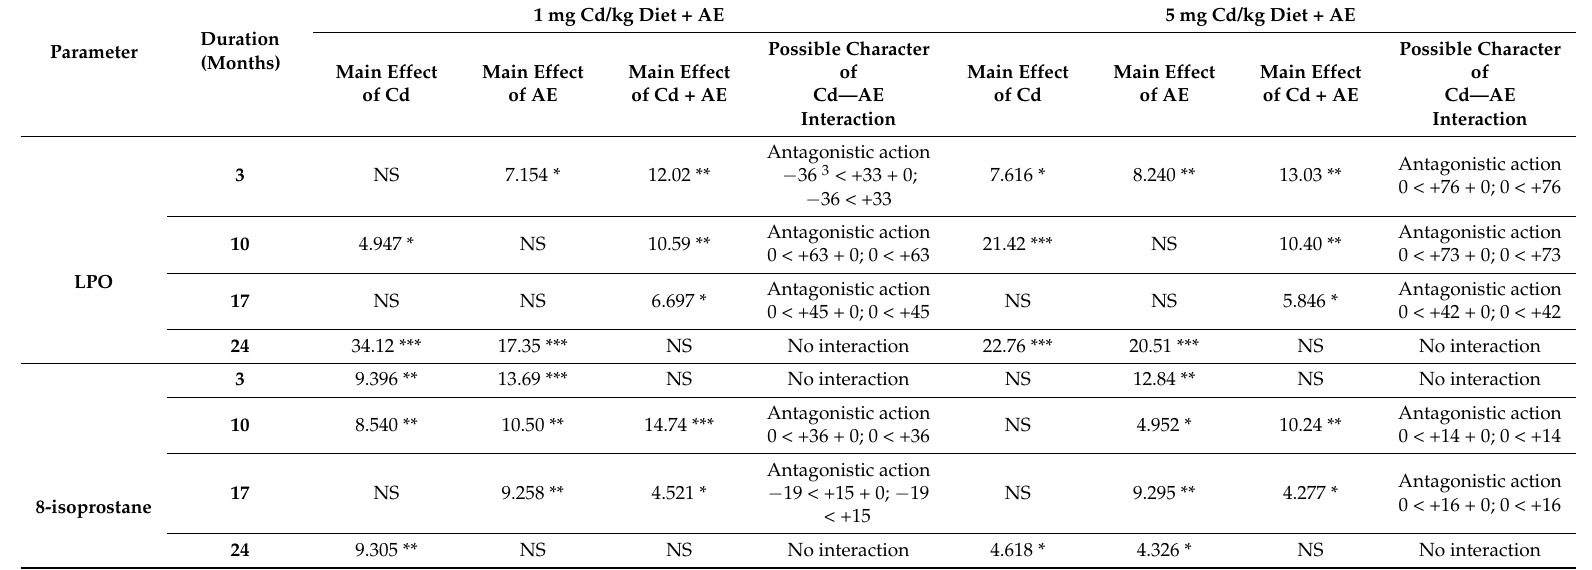
Table 1. Main and interactive effects of cadmium (Cd) and the extract from Aronia melanocarpa L. berries (AE) on the concentrations of lipid peroxides (LPO) and 8-isoprostane in the liver of female rats. 1,